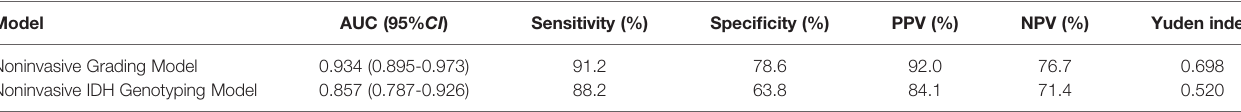
TABLE 8 | Diagnostic ef fi ciency of multivariate Logistic regression